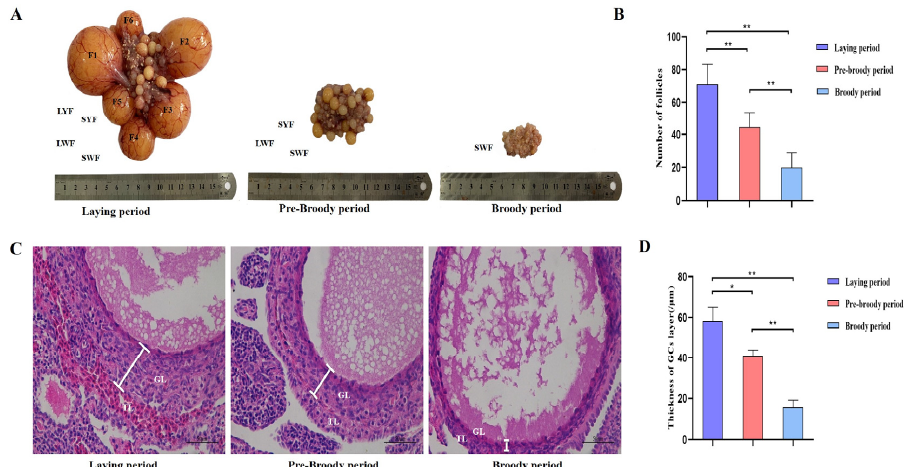
Figure 1. Morphological and histological characteristics of follicles during goose broodiness. ( A ) Ovarian morphology during the process of goose brooding (including the laying, pre-broody and broody periods). F1, F2, F3, F4, F5 and F6 represent the first, second, third, fourth, fifth and sixth yellow hierarchical follicles, respectively. LYF and SYF indicate large and small prehierarchical yellow follicles with diameters <7 mm, and LWF and SWF respectively represent large and small white follicles with diameters <5 mm. ( B ) Total number of hierarchical and prehierarchical follicles in goose ovaries ( n = 5). ( C ) Representative morphology of ovarian LWF follicle tissues demonstrated by H&E staining. TL indicates the theca layer; GL indicates the granulosa layer. Scale bar = 100 μ m. ( D ) The diversification of the thicknesses of the GC layer was calculated using ImageJ2x software ( n = 5). The deviation of 3 areas was randomly selected from each slice for image acquisition, and 3 areas were randomly selected from each image for measurement. * indicates a significant difference ( p < 0.05) and ** indicates an extremely significant difference ( p < 0.01).